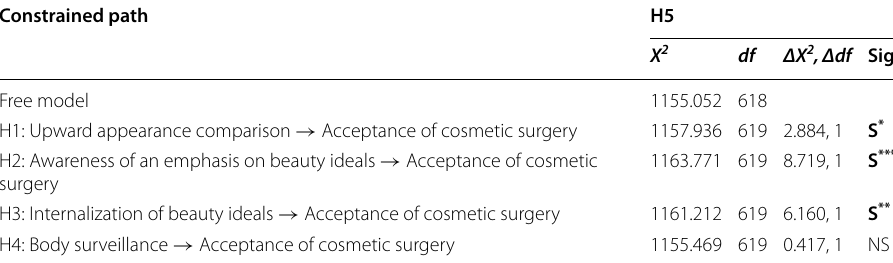
Table 7 Results of testing hypothesis 5